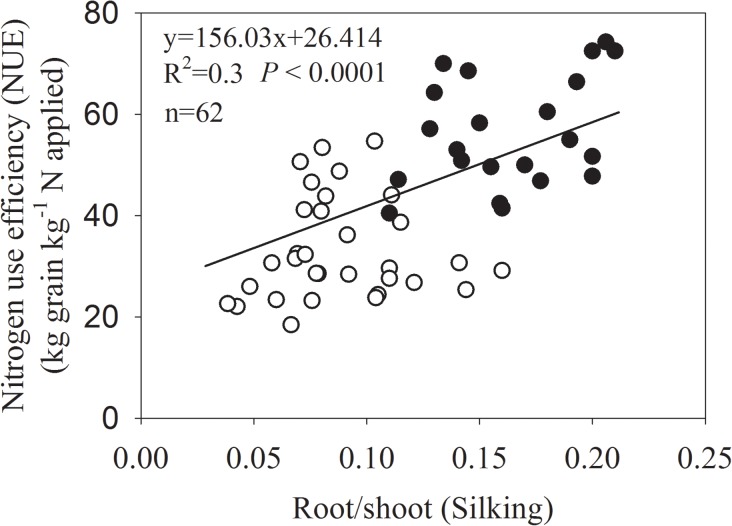
Correlation between the maize root/shoot ratio and nitrogen use efficiency (NUE) at silking.Only data published with root/shoot ratio at silking, grain yield at maturity and total N fertilizer were used in this analysis. Open circles indicate the results from Chinese farmlands and closed circles indicate data from western countries.